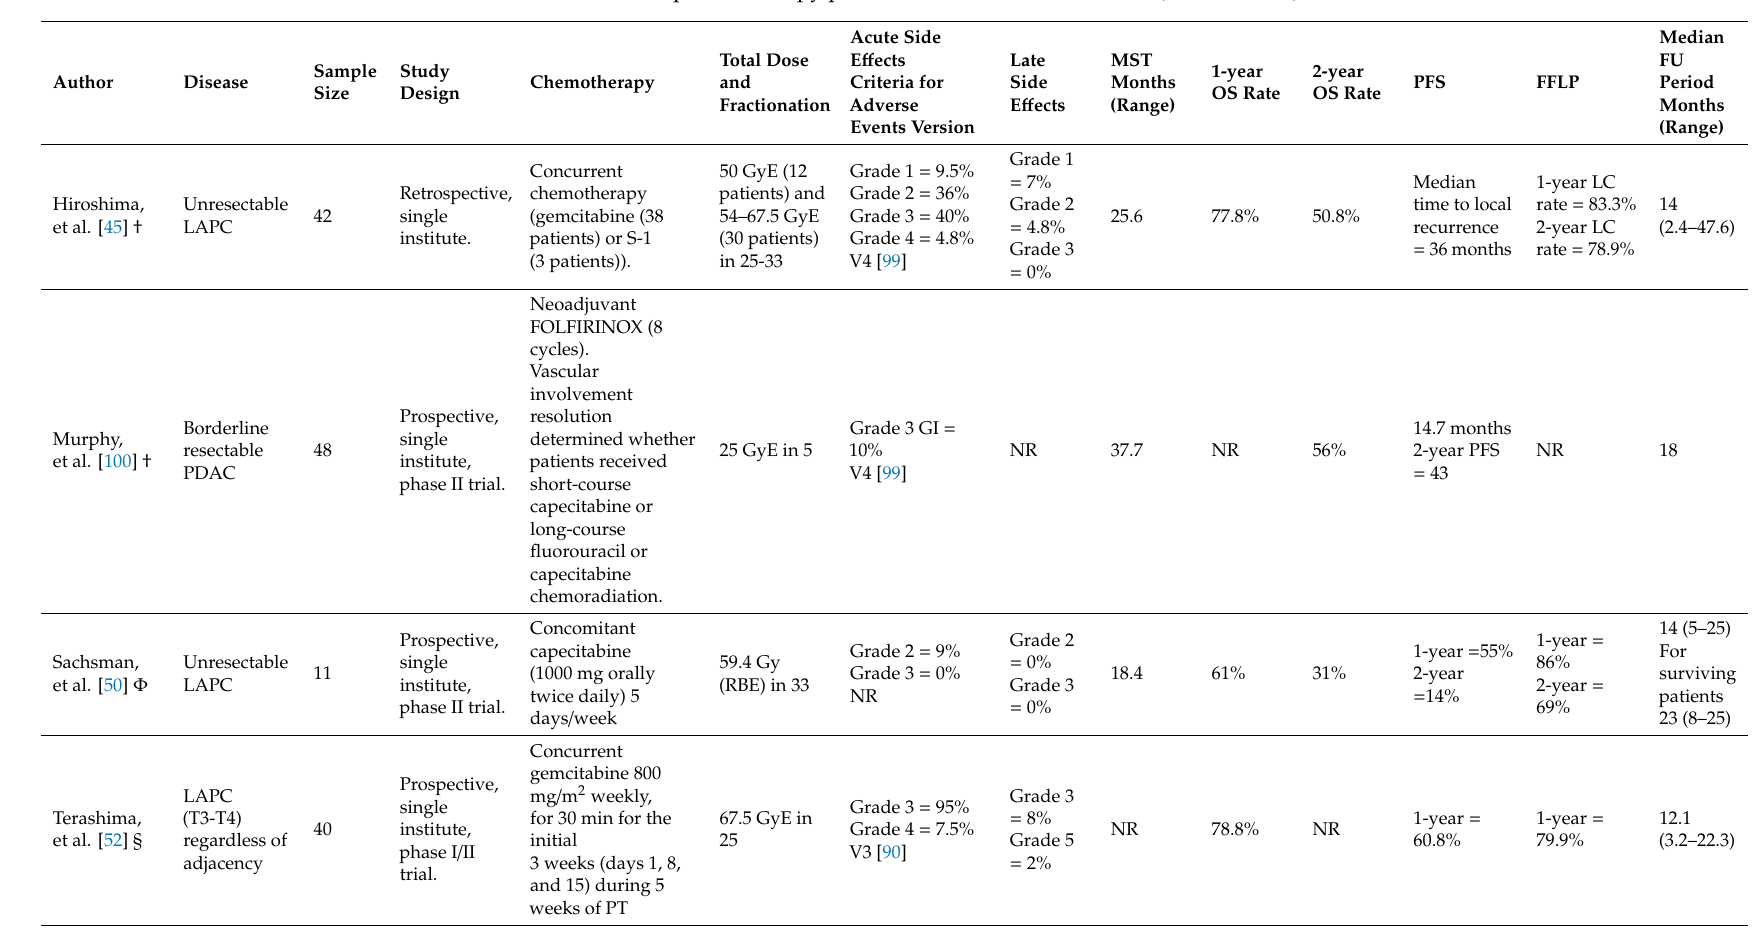
Table 3. Review of proton therapy pancreatic cancer clinical studies